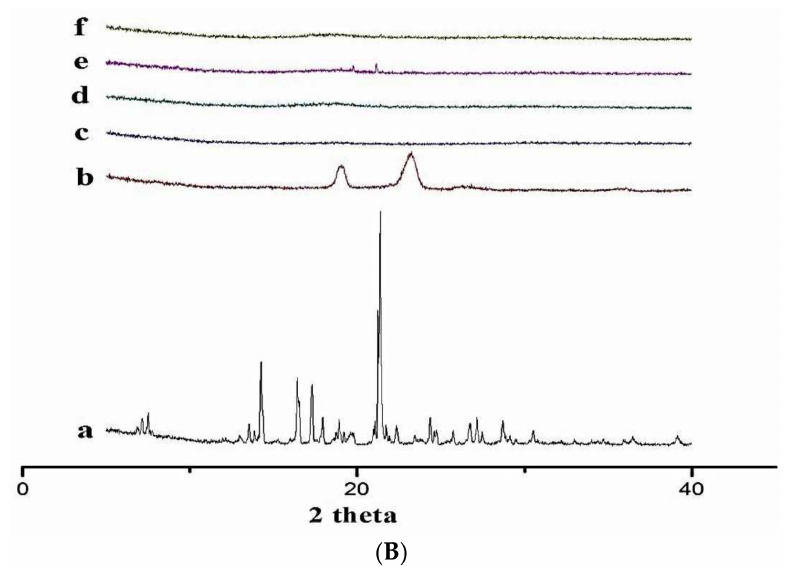
Figure 7. ( A ) XRD Diffractrograms of (a) DEX, (b) PXM-188, (c), 1:4 DEX:HP β CD, (d)